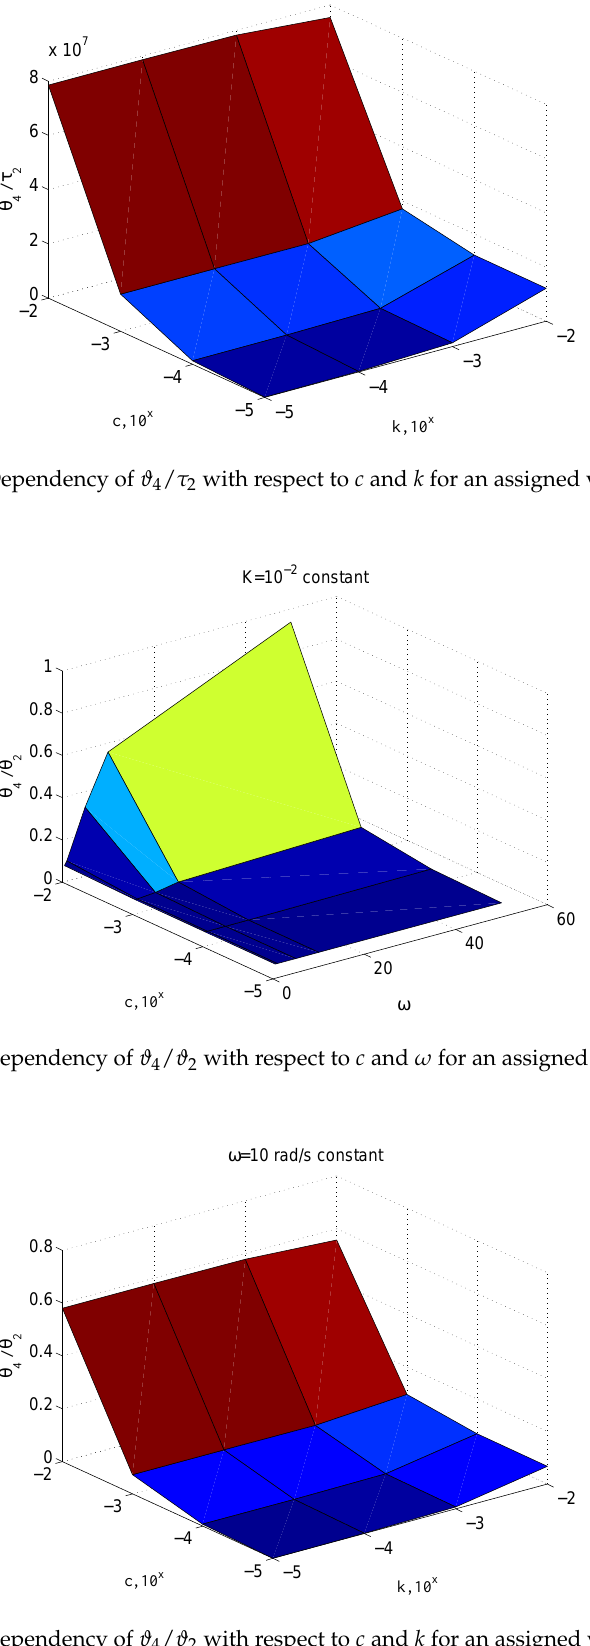
Figure 16. Dependency of ϑ 4 / ϑ 2 with respect to c and k for an assigned value of ω